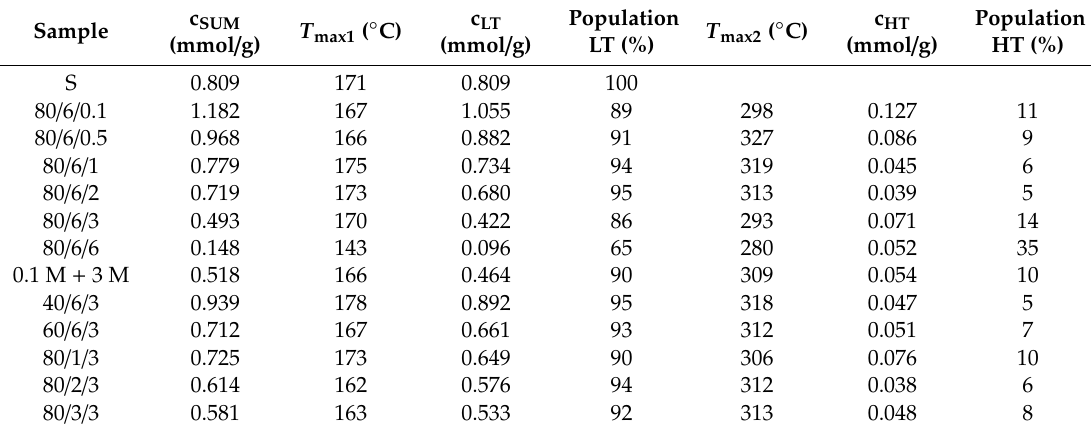
Table 4. Acidity of zeolite foam pellets modified by HCl, determined by NH 3